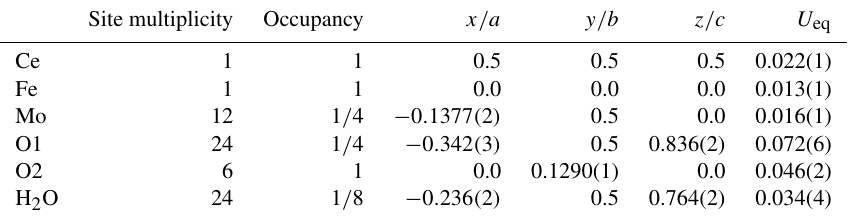
Table 5. Site occupancies, atom coordinates, and equivalent displacement parameters in the average cubic structure of